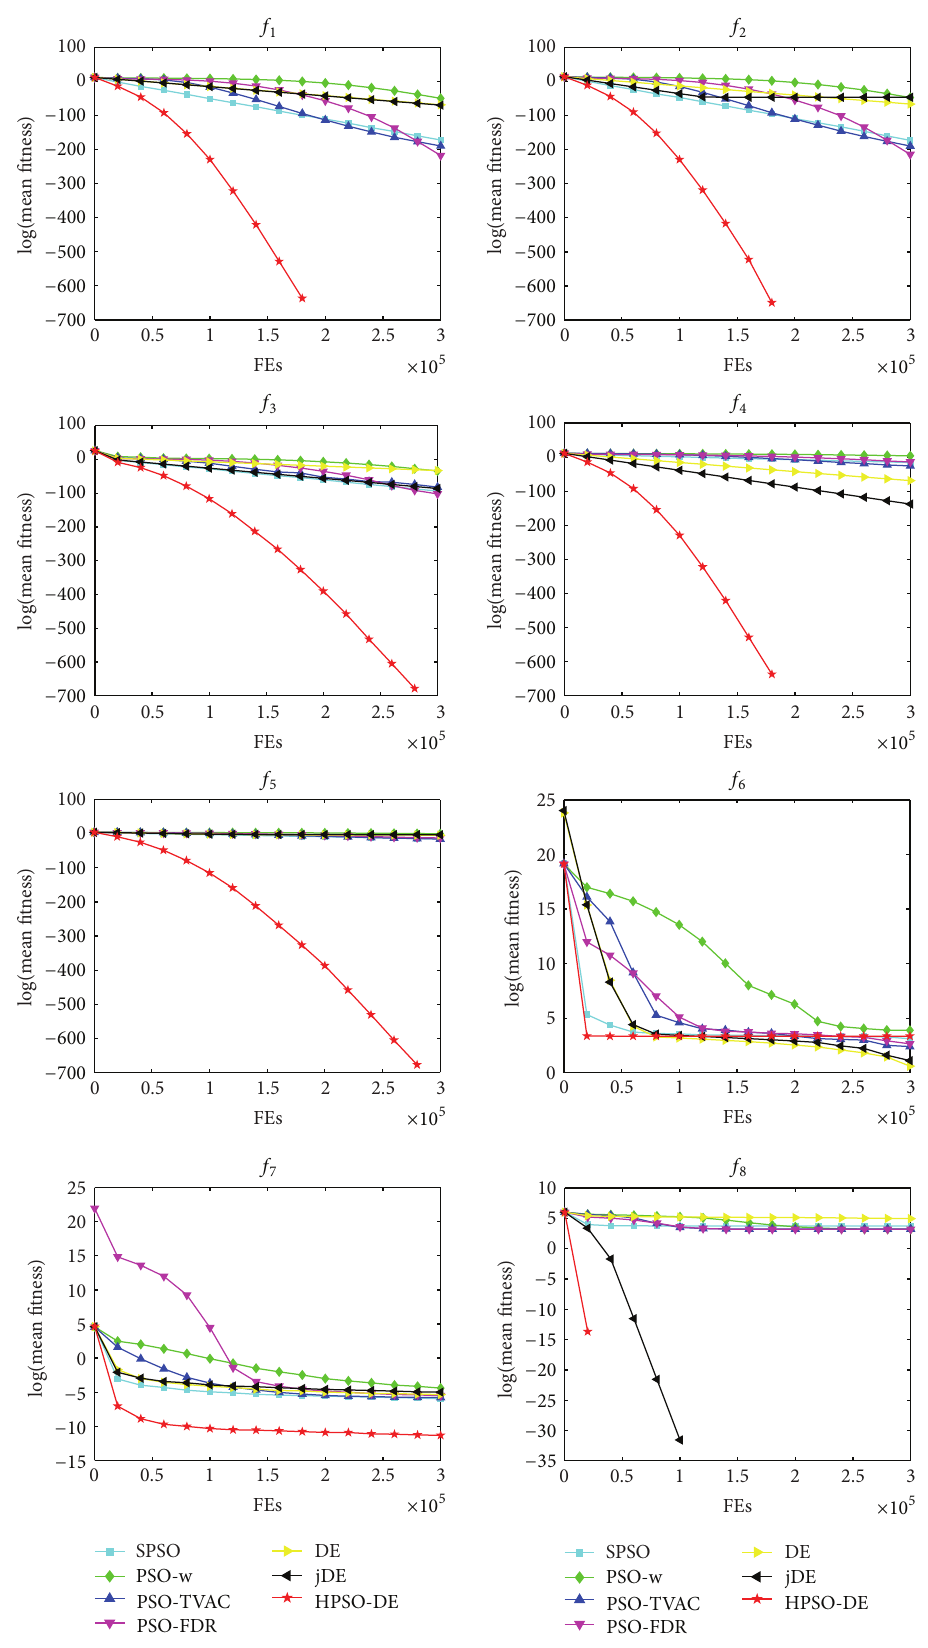
Figure 1: Performance of the algorithms for 𝑓 1 , 𝑓 2 , 𝑓 3 , 𝑓 4 , 𝑓 5 , 𝑓 6 , 𝑓 7 , and 𝑓 8